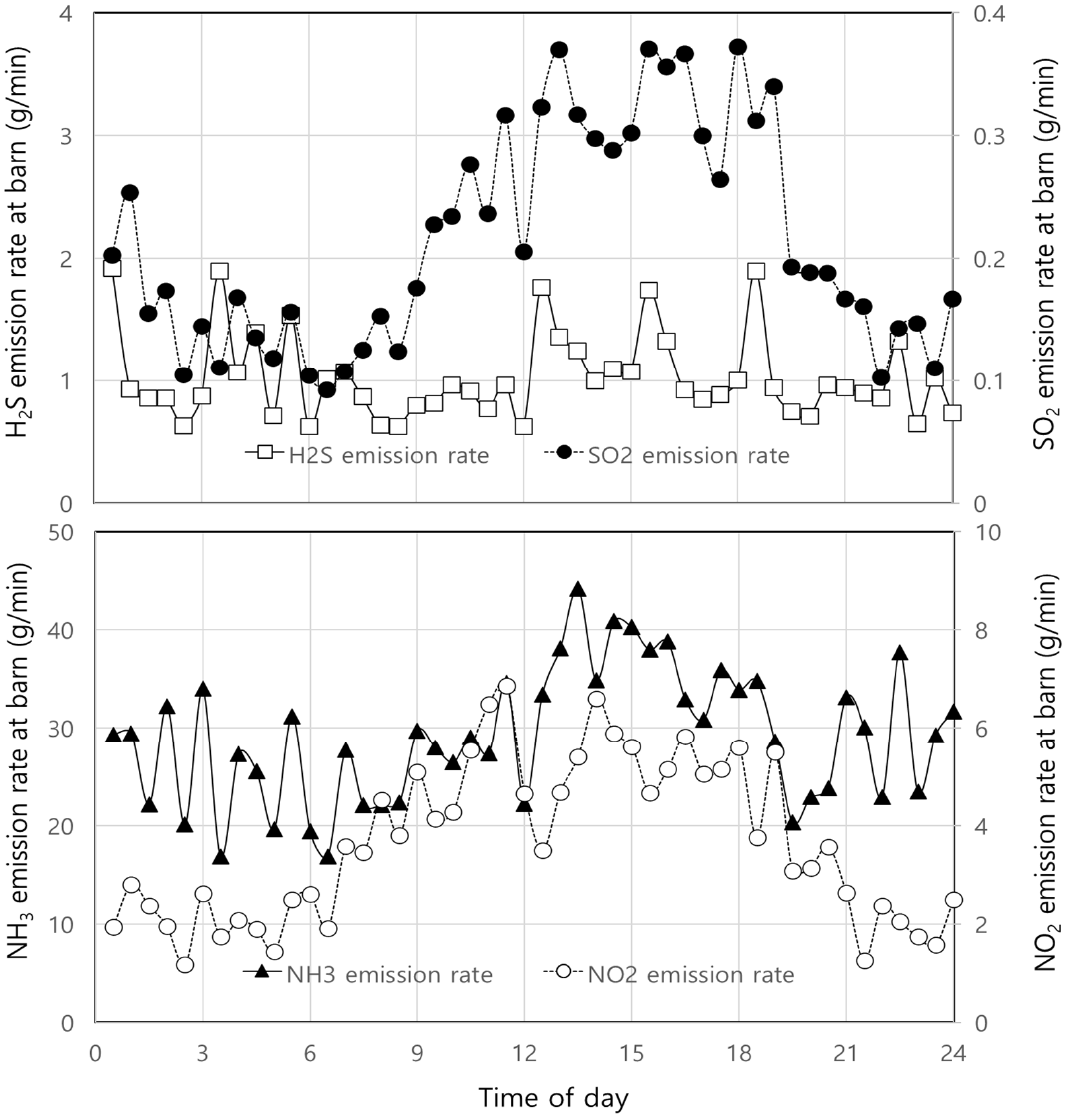
Figure 5. Diurnal patterns of hydrogen sulfide and sulfur dioxide emission rates (upper) and ammonia and nitrogen dioxide emission rates in the barns (bottom).